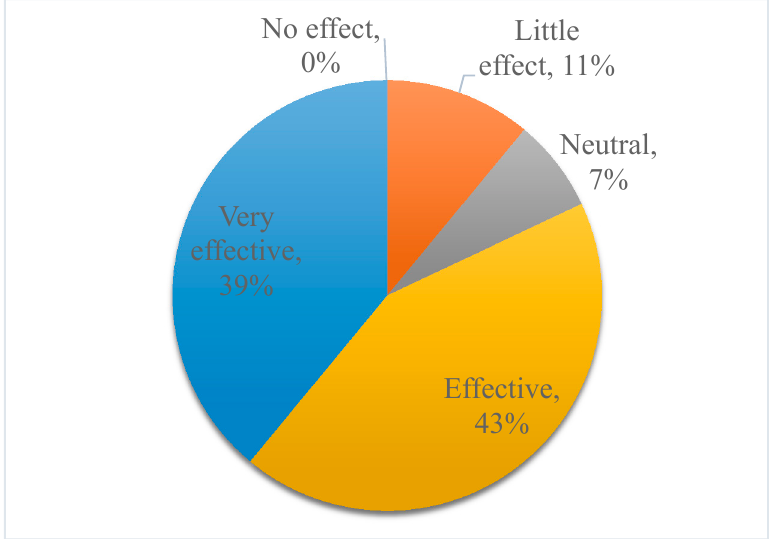
Figure 8. Percent response regarding the effectiveness of Lean methodology.